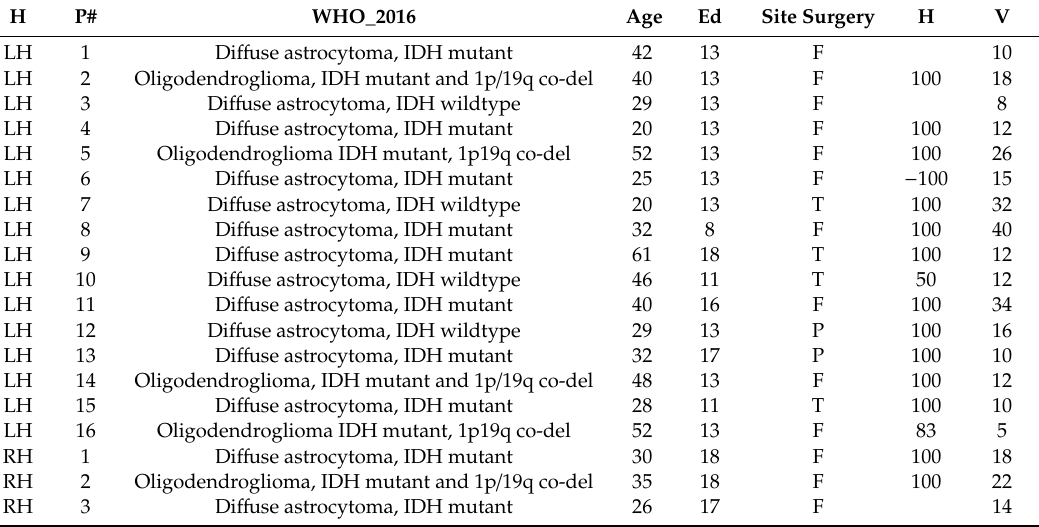
Table 1. iLGGs patients’ demographic and clinical